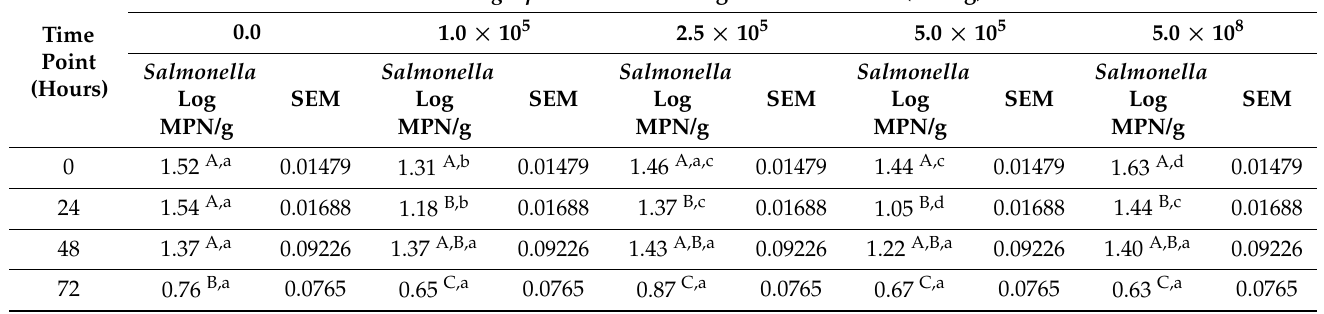
Table 2. Mean concentration (log 10 MPN/g) of naturally occurring Salmonella in non-inoculated cattle feces at 0, 24, 48, and 72 h following treatment with varying concentrations of Megasphaera elsdenii as an in vitro model.